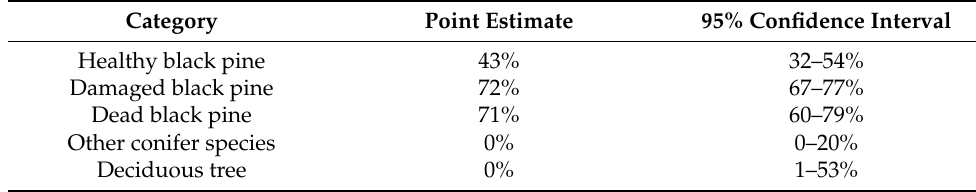
Table 2. F 1 scores of the final model across all